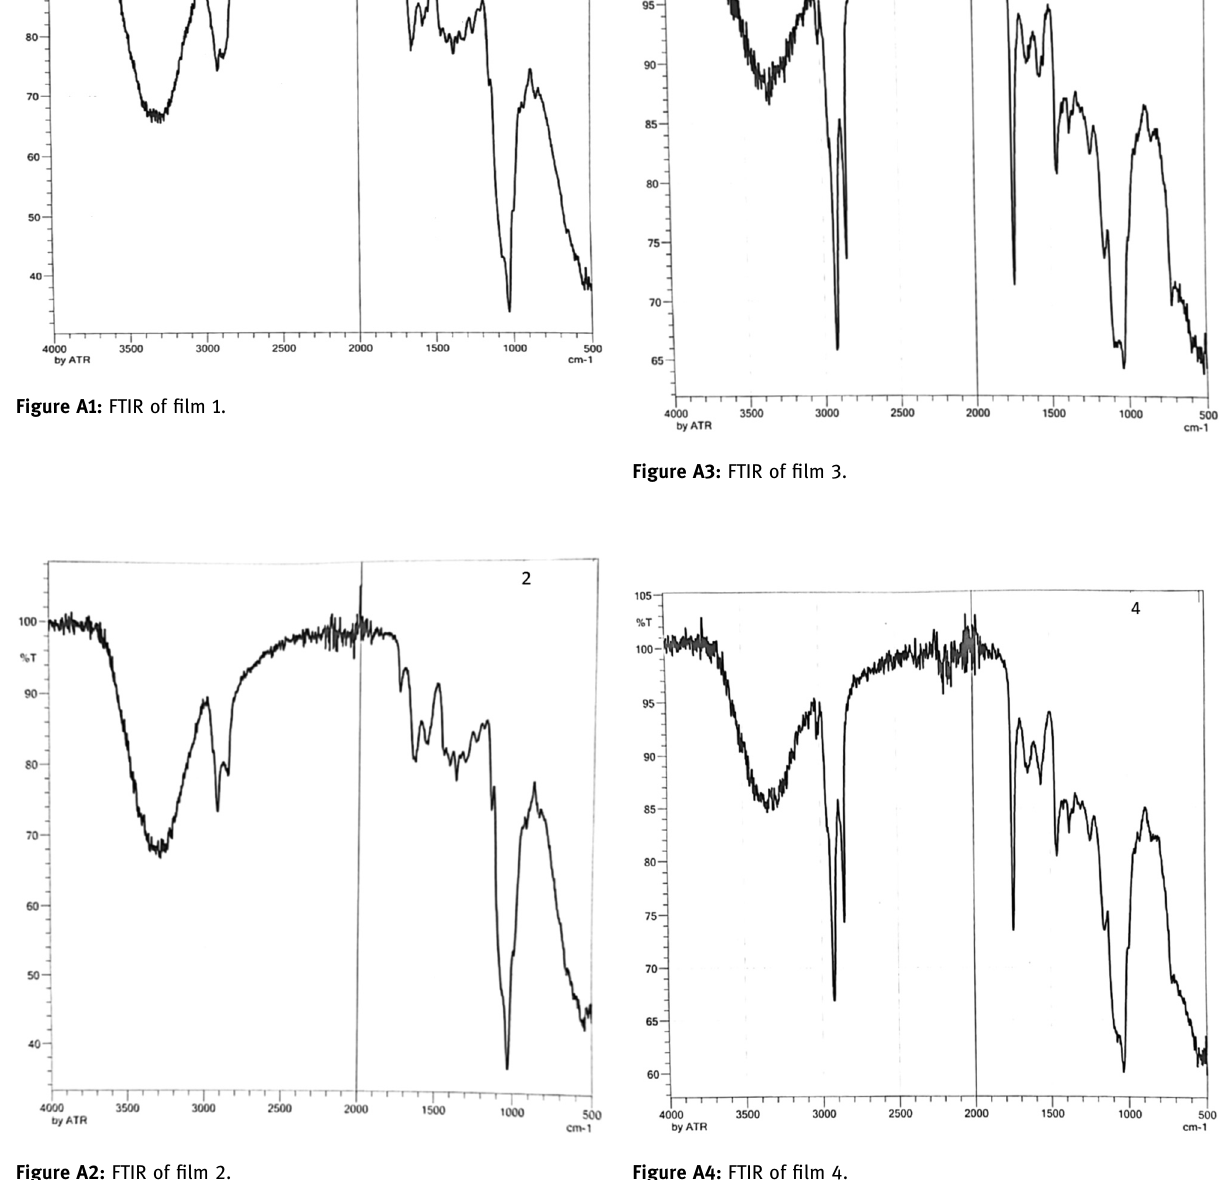
Figure A4: FTIR of fi lm 4. Figure A2: FTIR of fi lm 2.